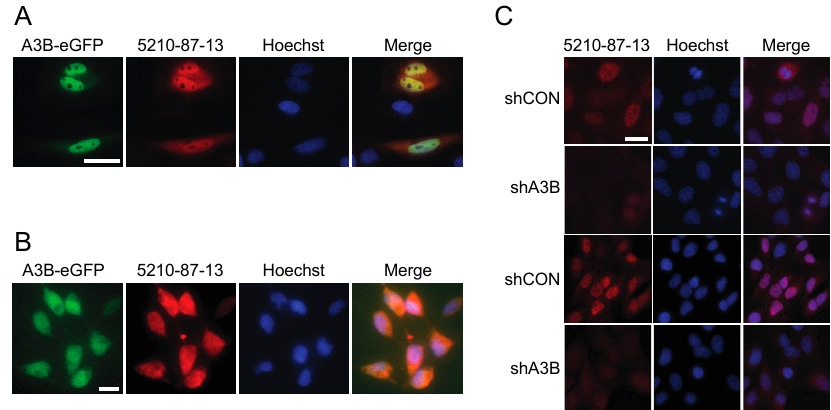
Figure 2. Immunofluorescent (IF) microscopy results for the 5210-87-13 mAb: ( A ) IF microscopy images of HeLa expressing A3B-eGFP and stained with the 5210-87-13 mAb (scale bar is 10 µm); ( B ) IF microscopy images of doxycycline-induced T-REx-293-A3B-eGFP cells stained with the 5210-87-13 mAb (scale bar is 10 µm); and ( C ) IF microscopy images of 5210-87-13 stained U2OS cells expressing a control shRNA (shCON) or shA3B (scale bar is 10 µm). Data from two independent experiments are provided for each condition, to show the reproducibility of this result.